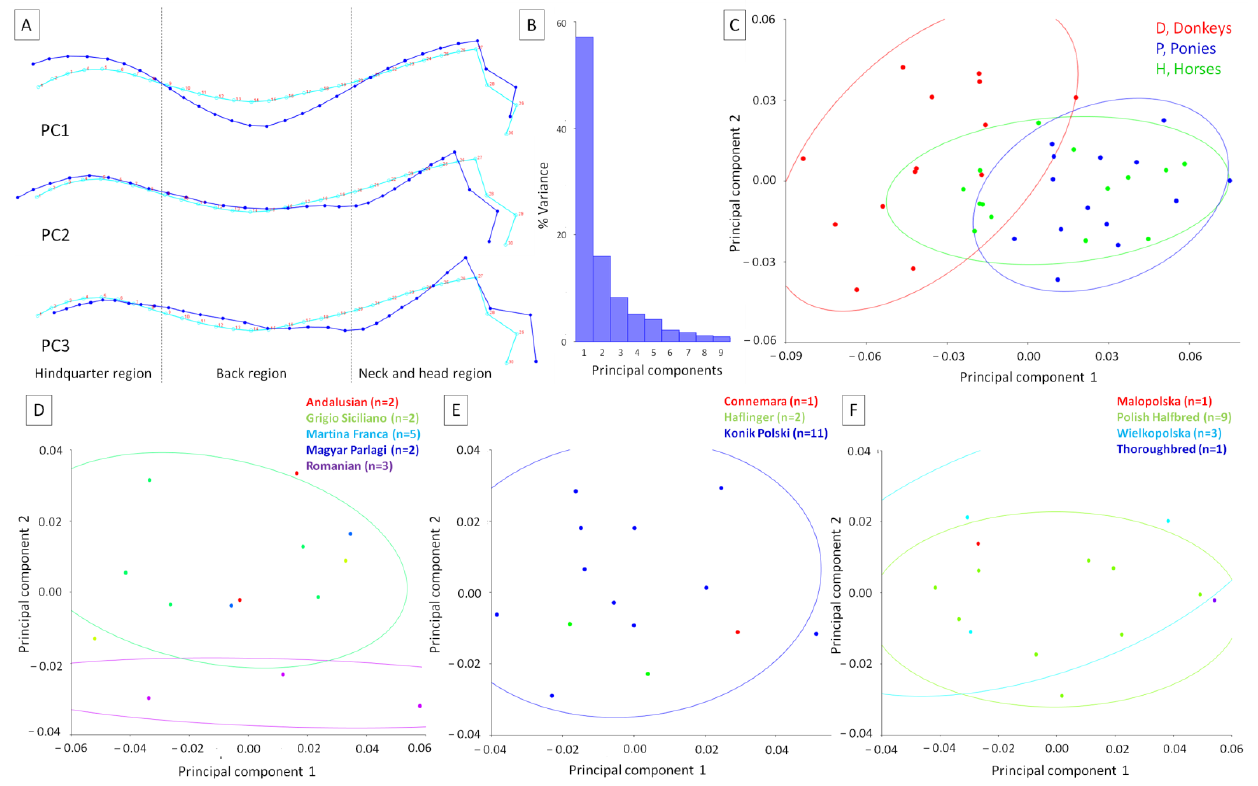
Figure 2. Principal components (PCs) of the dorsal profiles of equids are represented by ( A ) the wireframe graph, ( B ) the histogram of variance, and ( C – F ) the scatter plot of the PCs scores of the equids. On the wireframe graph ( A ), light blue landmarks and curves represent the consensus animal’s dorsal profile. Dark blue landmarks and curves represent the extremum (minimum of the axis) values for PC1, PC2, and PC3, respectively. Dashed lines indicate the boundaries between regions. For the general scatter plot of the PC scores ( C ), the color for each group was determined based on the classifier variables: D, donkeys; P, ponies; H, horses. For the detailed scatter plots of the PC scores ( D – F ), the color of each breed with the number of individuals (n) is shown for donkeys ( D ), ponies ( E ), and horses ( F ). The confidence ellipses were drawn using a 0.9 probability and a classifier as a criterion for grouping the observations.